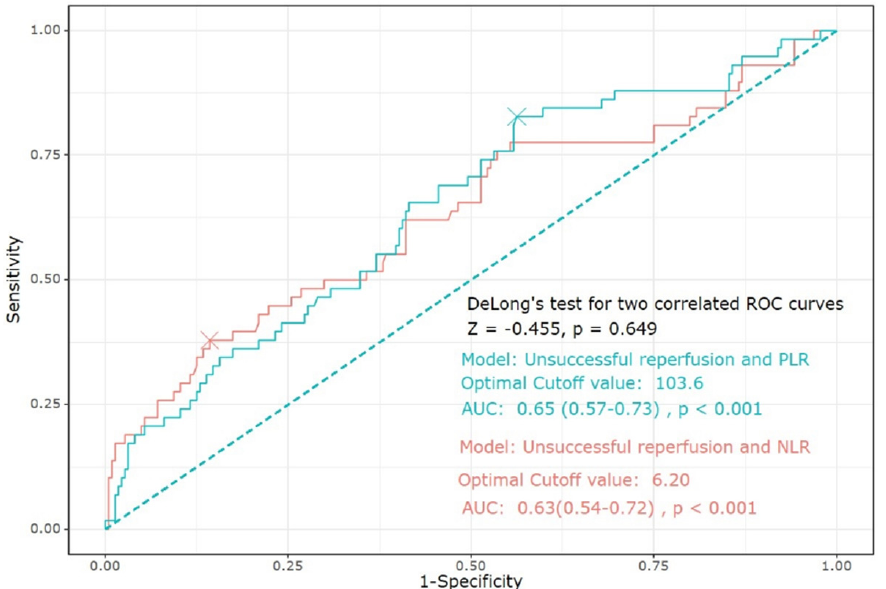
Figure 2. The ROC curve showing the predictive ability of both NLR and PLR for unsuccessful reperfusion. Abbreviations: ROC, receiver operating characteristic; NLR, neutrophil-to-lymphocyte ratio; PLR, platelet-to-lymphocyte ratio.